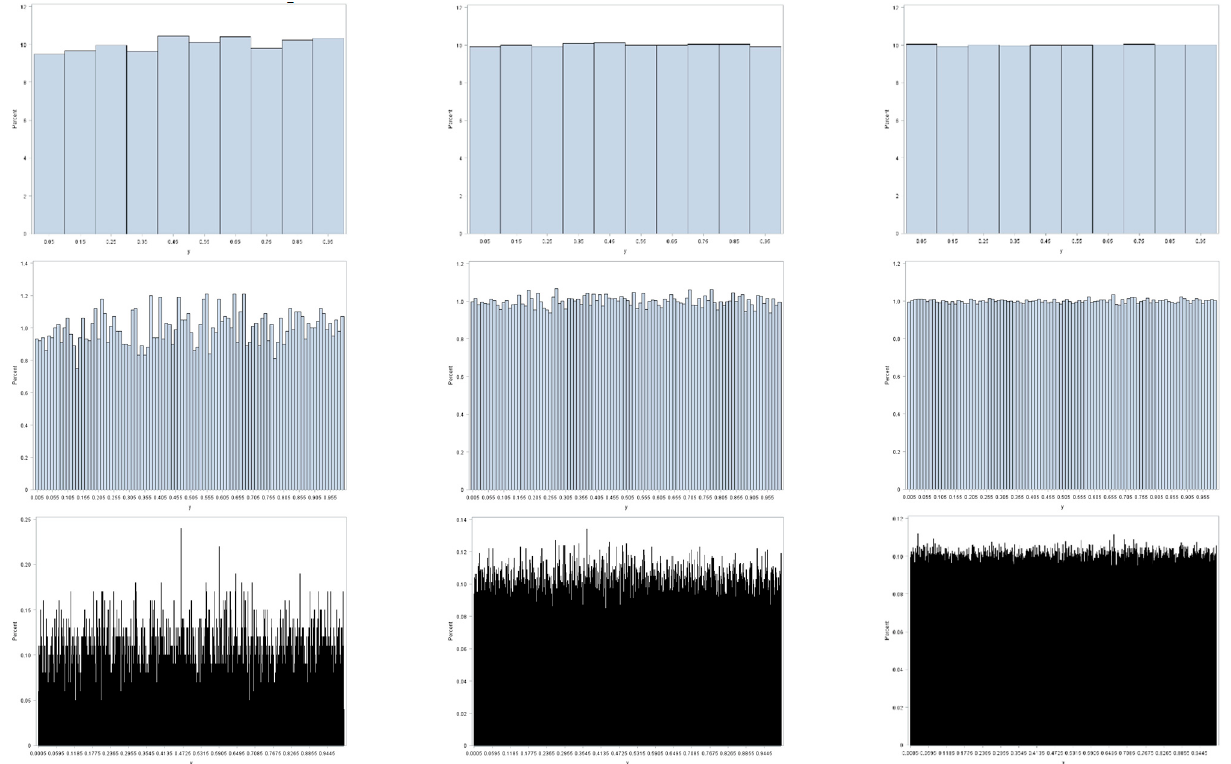
Figure 1. Histograms for random samples from a continuous uniform distribution. Sample size n : left—10,000; middle— 100,000; right—1,000,000. Bin size: top—0.1; middle—0.01; bottom—0.001.